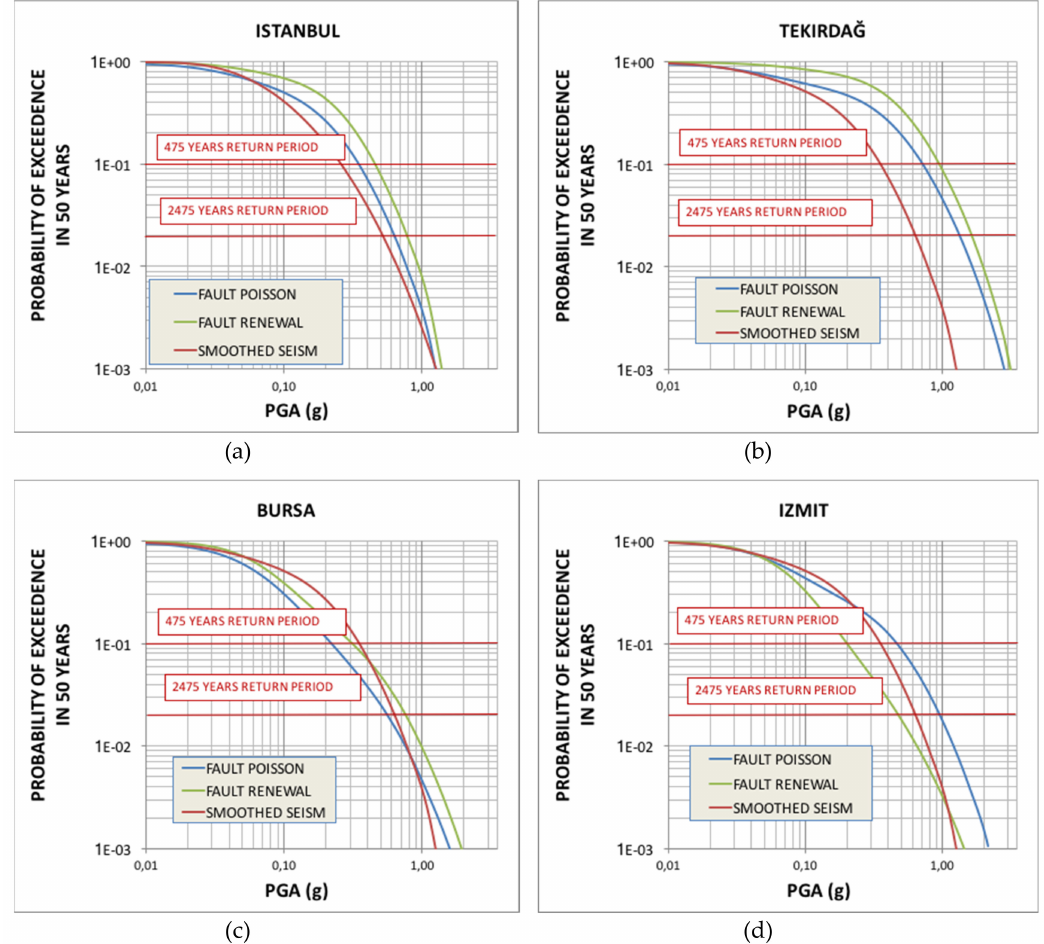
Figure 15. The PGA hazard curves for ( a ) Istanbul, ( b ) Tekirda˘g, ( c ) Bursa, and ( d ) Izmit (Kocaeli) considering the individual Poisson, renewal-BPT and smoothed seismicity source models.